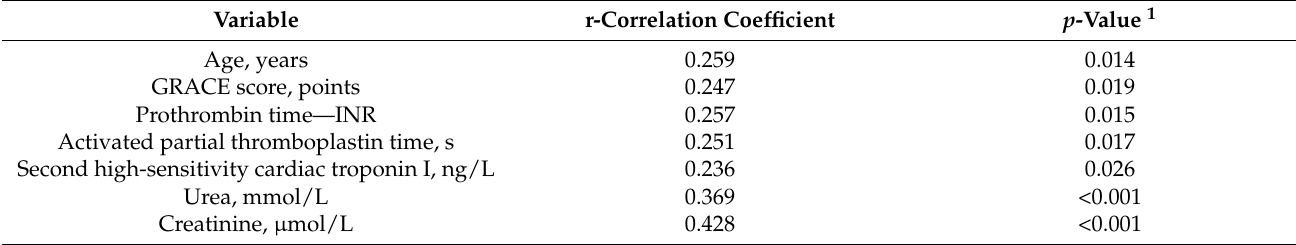
Table 2. Significant univariate Pearson’s correlations between dp-ucMGP plasma levels and anthropometric, clinical and laboratory